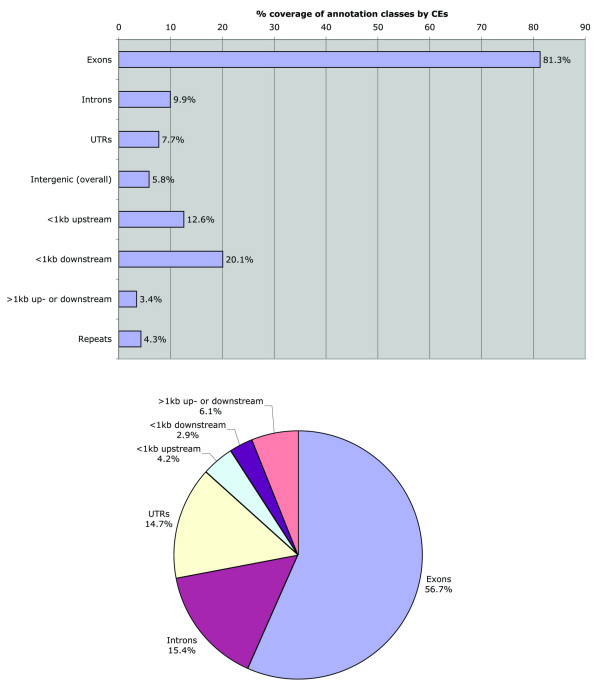
Characterisation of conserved elements in the tammar wallaby and human inflammatory regions. The proportion of bases in exons, introns, untranslated regions (UTRs), repeats, and intergenic sequence that are covered by conserved elements (top) and the proportion of conserved bases in each annotation class (bottom) for the wallaby-referenced sequence alignment.